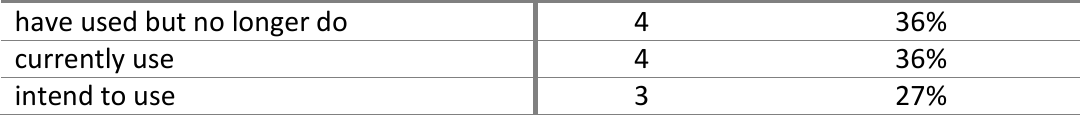
Table 25: NVQ responses to question "which of the following do you use, have used or intend to use for staff training and development?" n =11